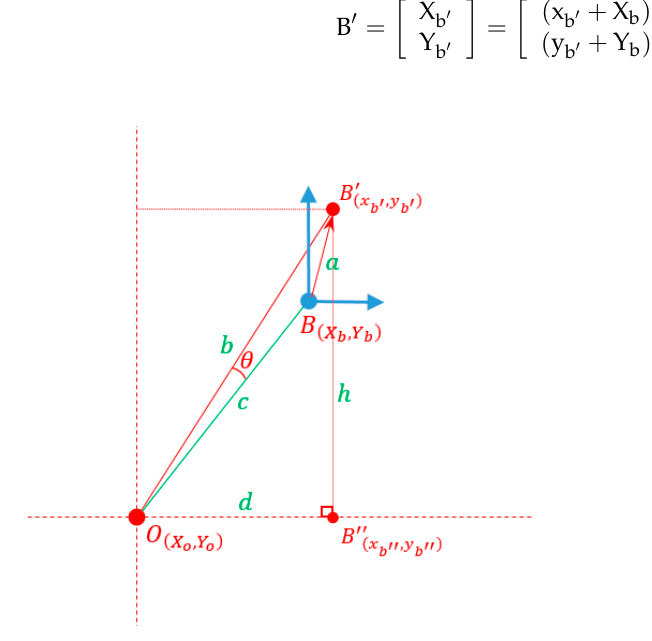
Figure 12. Applying the Cosine theorem.